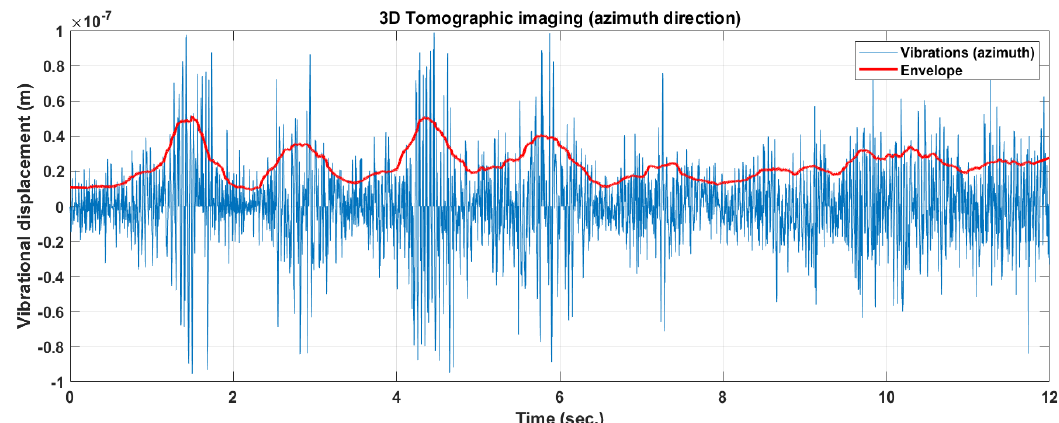
Figure 6. Time domain vibrations in the azimuth direction